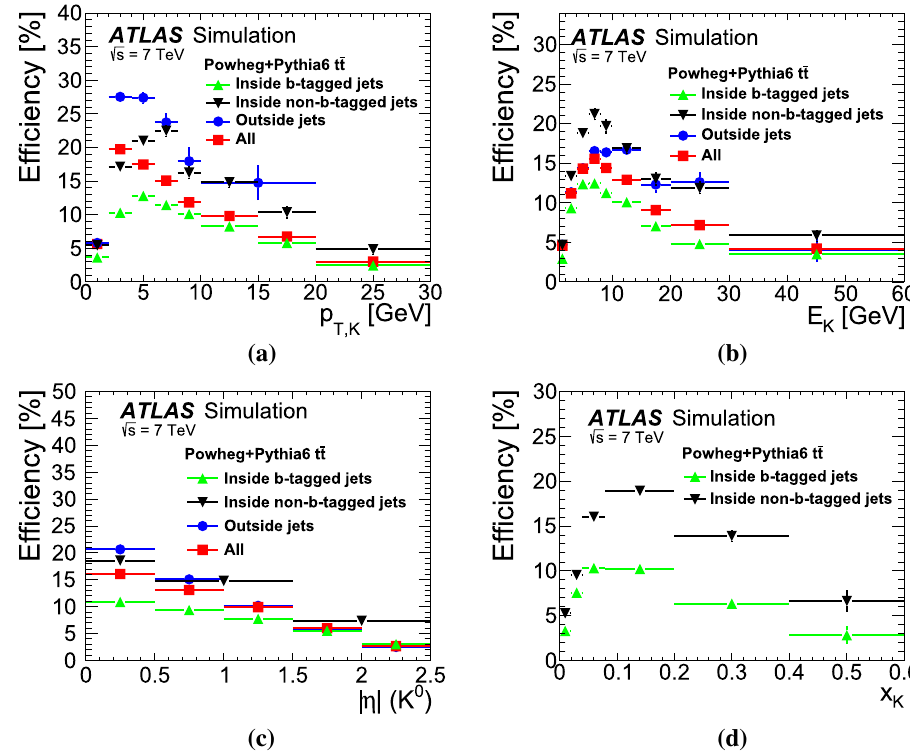
Fig. 7 The K 0 reconstruction S efficiency as a function of a p T , b energy, c | η | and d energy fraction for Powheg + Pythia6 and four classes of K 0 : inside S b -tagged jets (triangle), inside non- b -tagged jets (inverted triangle), outside any jet (circle), and the total sample